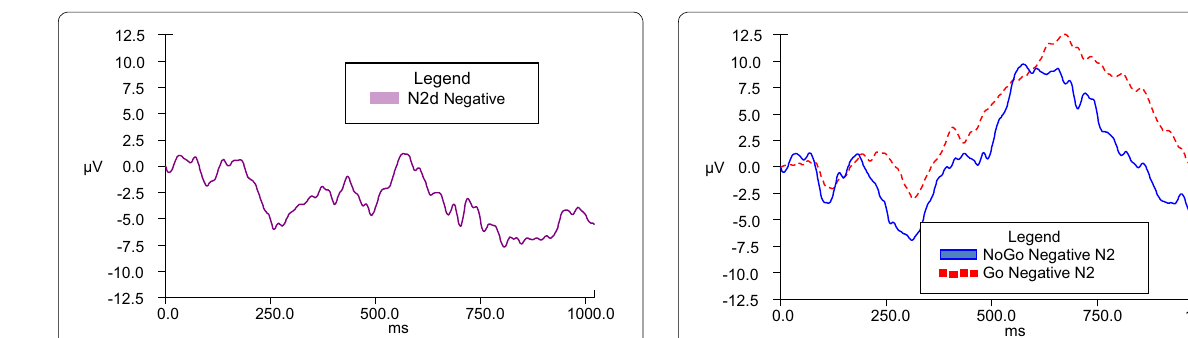
Fig. 6 Go and NoGo N2 ERP grand averages for 280-ms negative condition at electrode